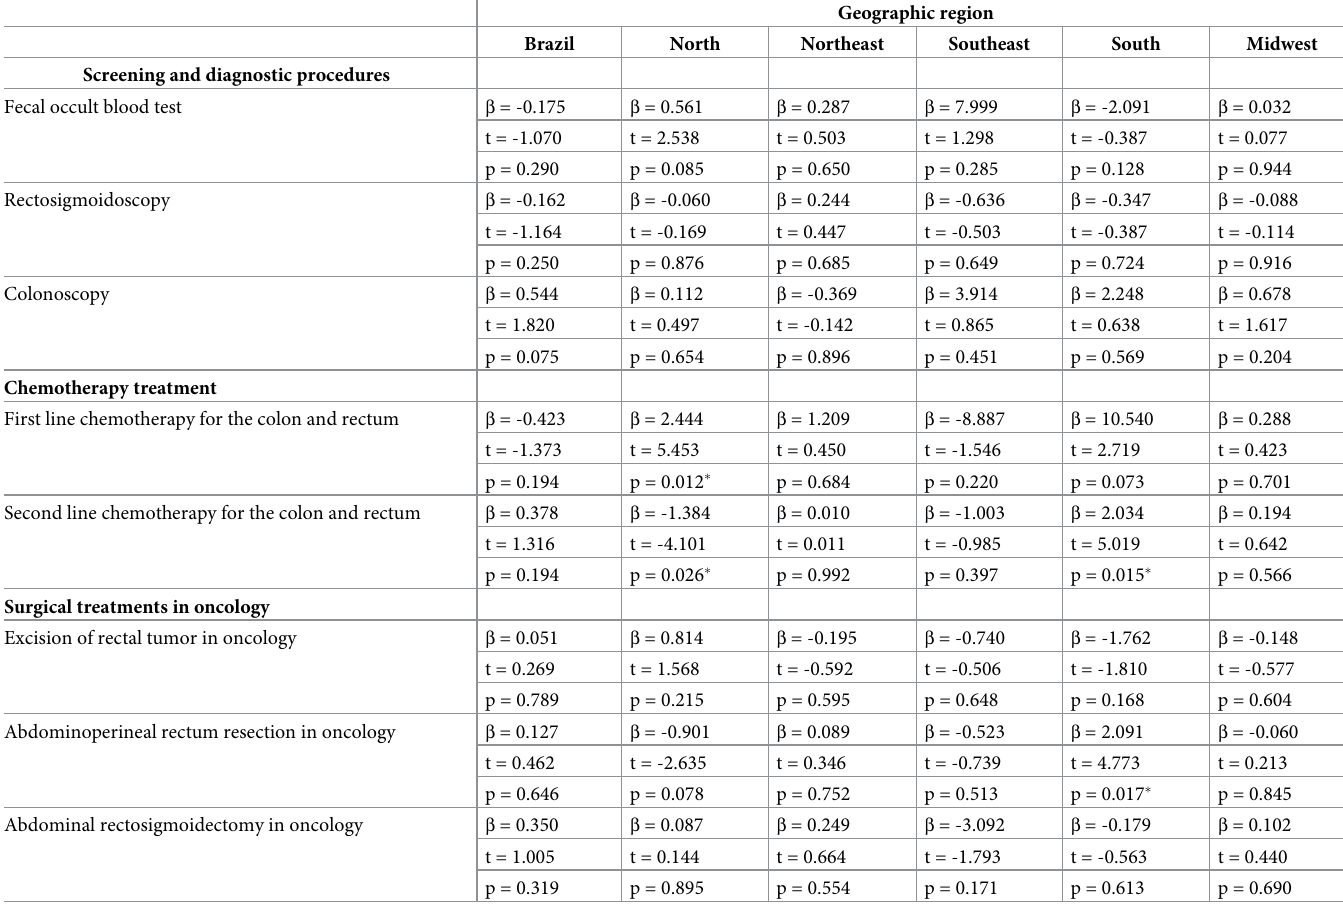
Table 3. Prediction of mortality in Brazil and different geographic regions by performing screening, diagnosis and treatment procedures for colorectal